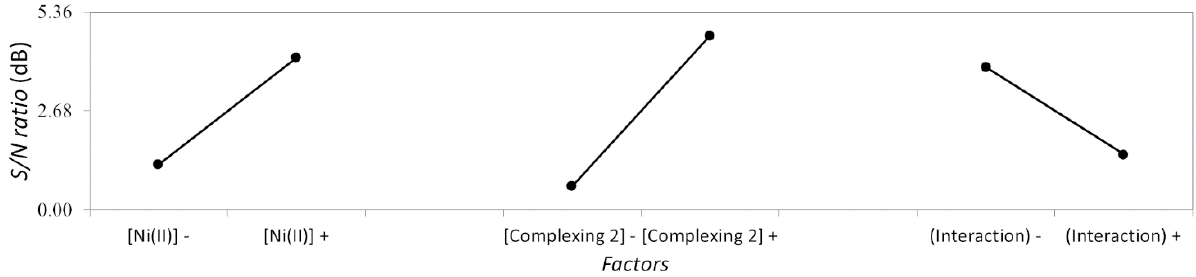
Figure 9. Main effect plot for a dedicated Taguchi design to determine the influence of Ni (II) and complexing agent 2 concentrations on the corrosion performance of ENP coatings.